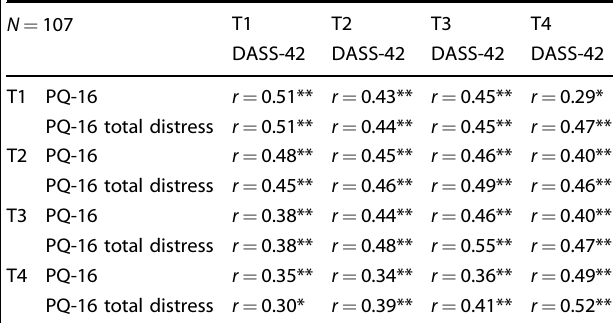
Fig. 1 DASS-42 and PQ-16 scores. The DASS-42 scores (stress, depression, anxiety) across time are on the left panel, and the PQ-16 sub-scores (unusual thought content, perceptual abnormalities, and negative symptoms) on the right panel. Scores are averaged over participants and displayed with SEM. Table 3. Correlations between DASS-42 and